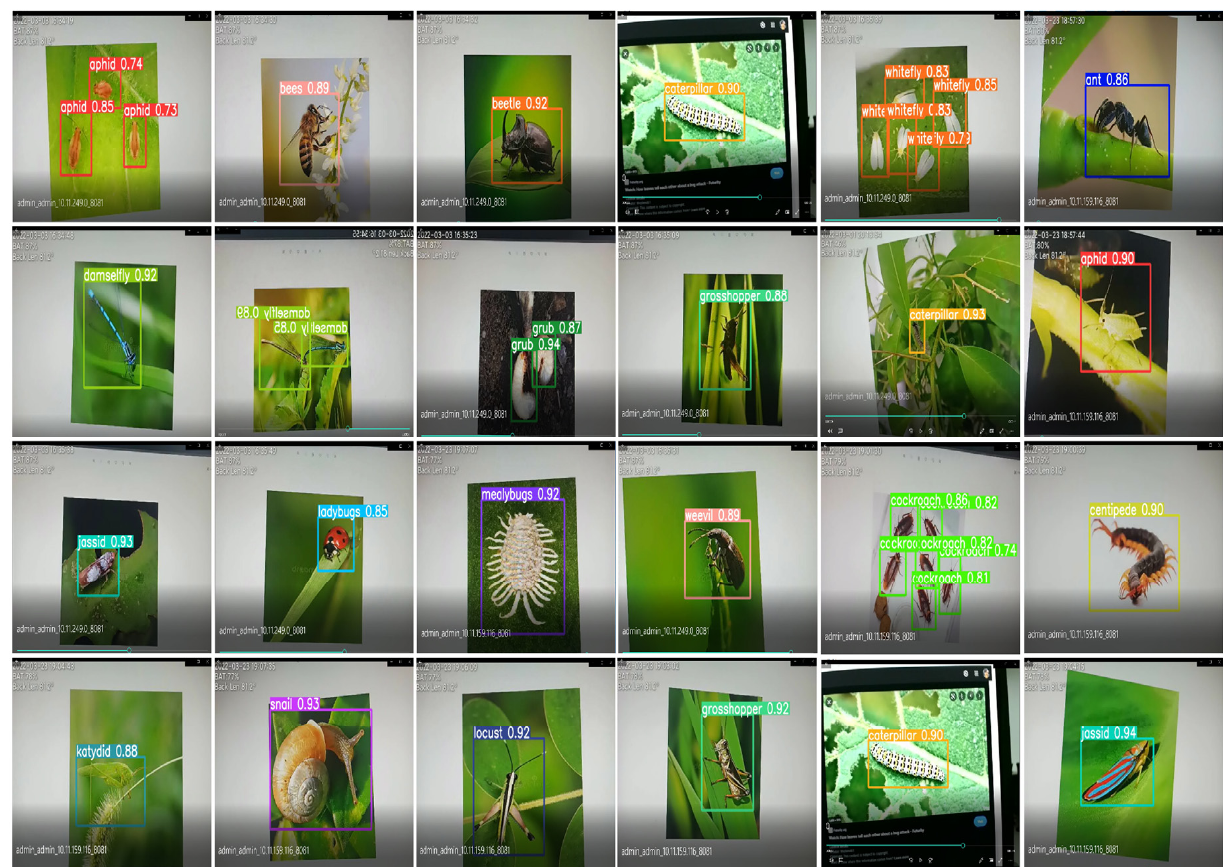
Figure 13. Detection results of the cell phone IP